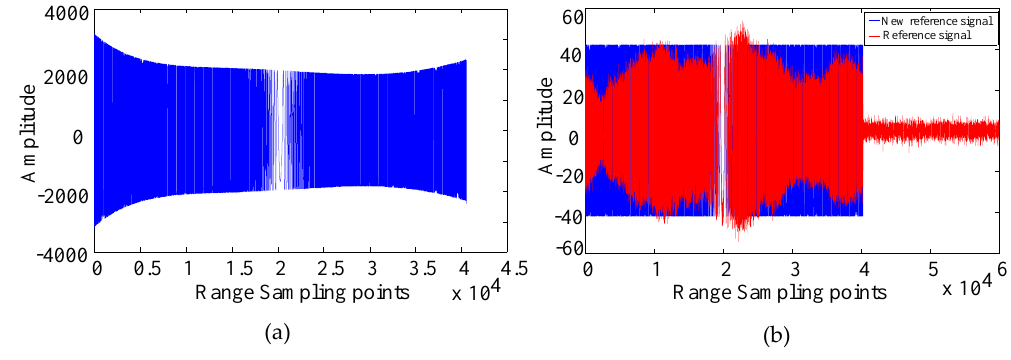
Figure 8. Reference signal and new reference signal . ( a ) I channel of the TerraSAR-X a priori signal (provided by DLR); ( b ) real part of reference signal (red) and new reference signal (blue).